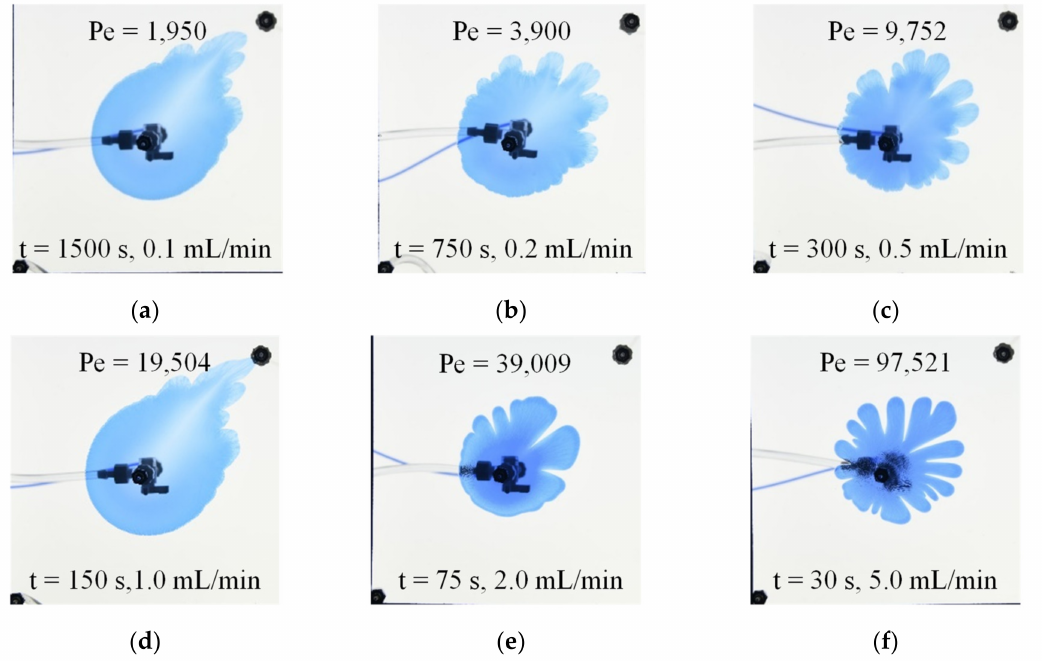
Figure 6. Water plume at 2.5 mL injected water for different injection rates under constant pressure control at the